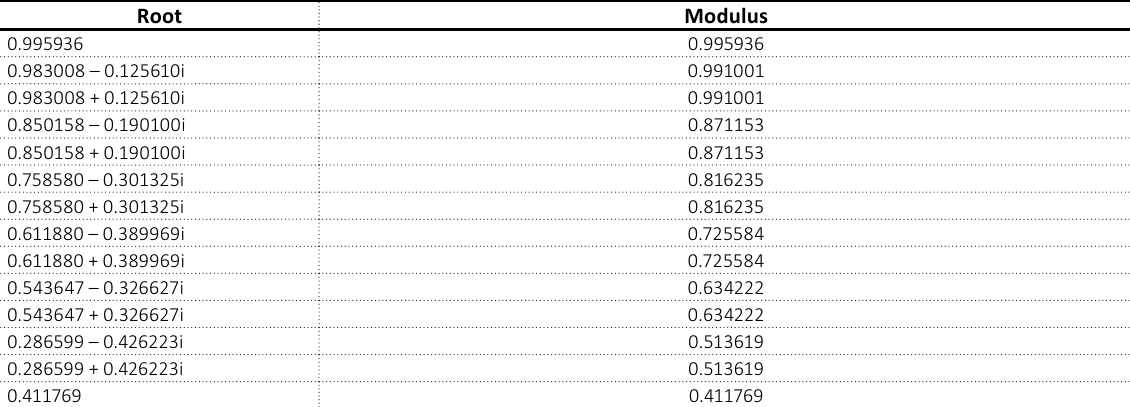
Table A3. Vector auto-regression stability